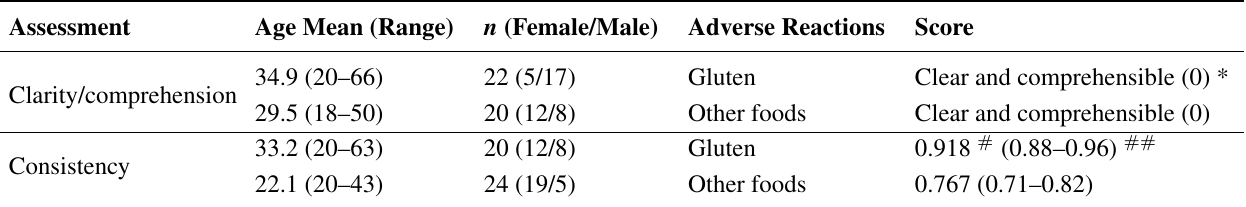
Table 1. Study population and test results of the designed questionnaire.